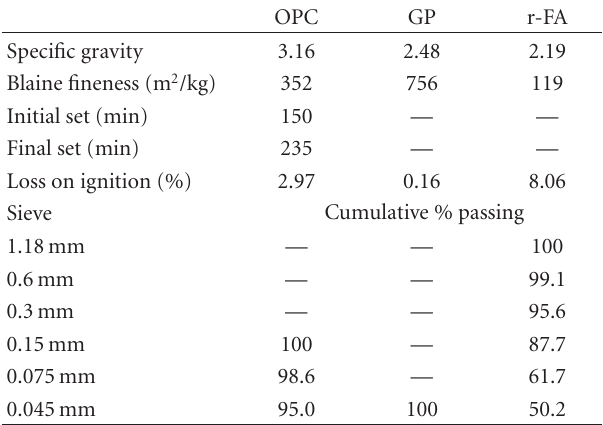
Table 2: Properties of Portland cement (OPC), recycled glass powder (GP), and rejected fly ash